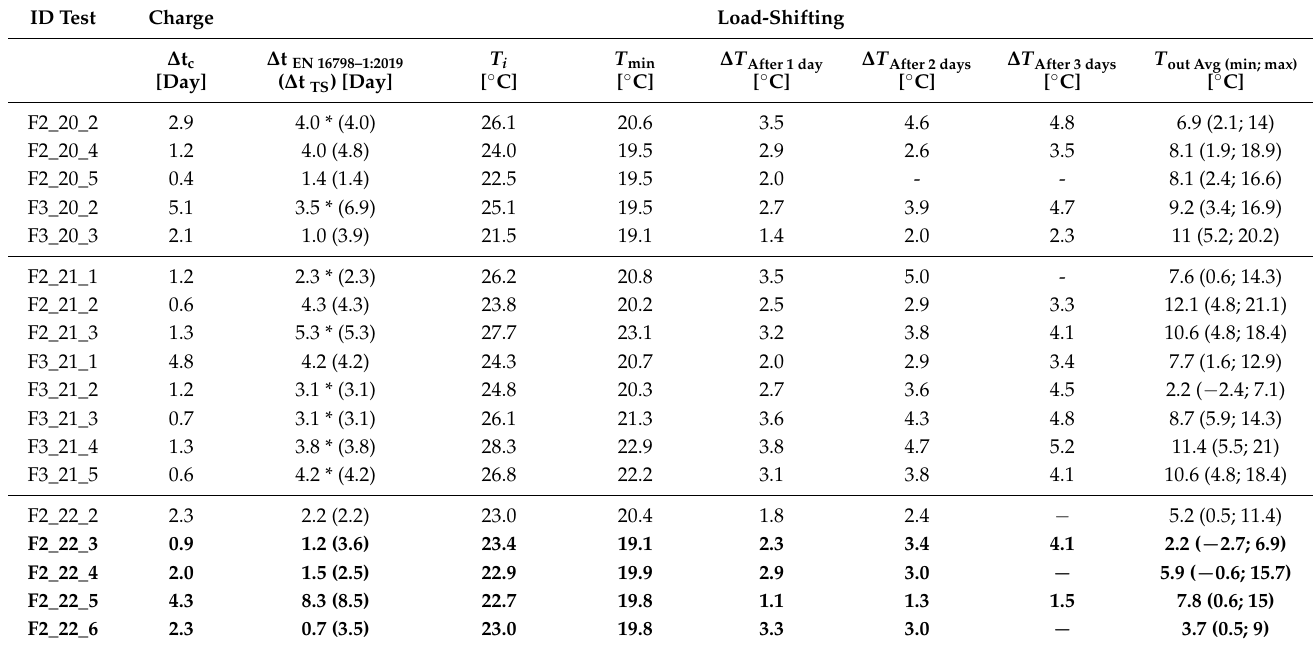
Table 6. Flexibility tests carried out during the winter season over the years 2020 and